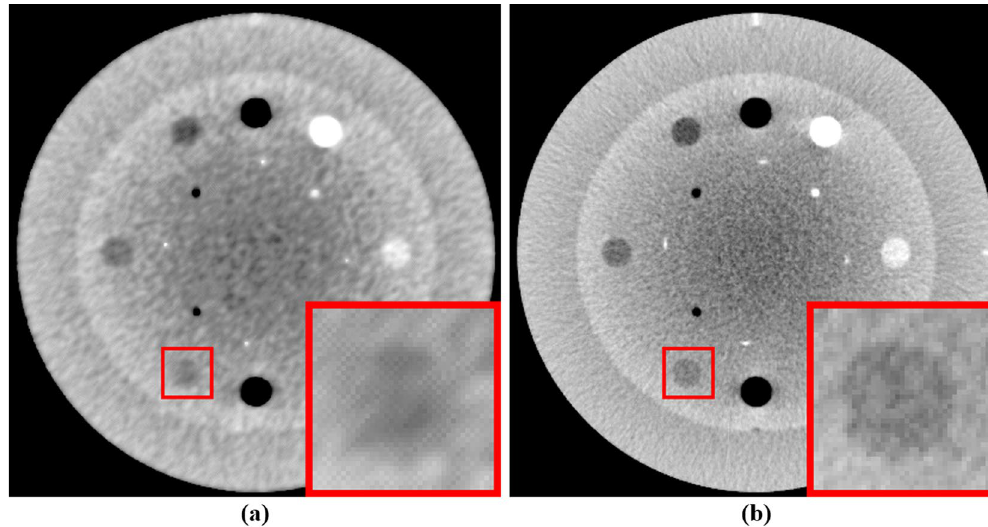
Figure 10. Comparison between high resolution CBCT images generated by applying ( a ) NLTV on FDK reconstructed images as a post-processing strategy and ( b ) FDK with NLTV-denoised projection data as a pre- processing strategy. These Catphan503 phantom images are displayed at window (width and level) settings of (750, 0)